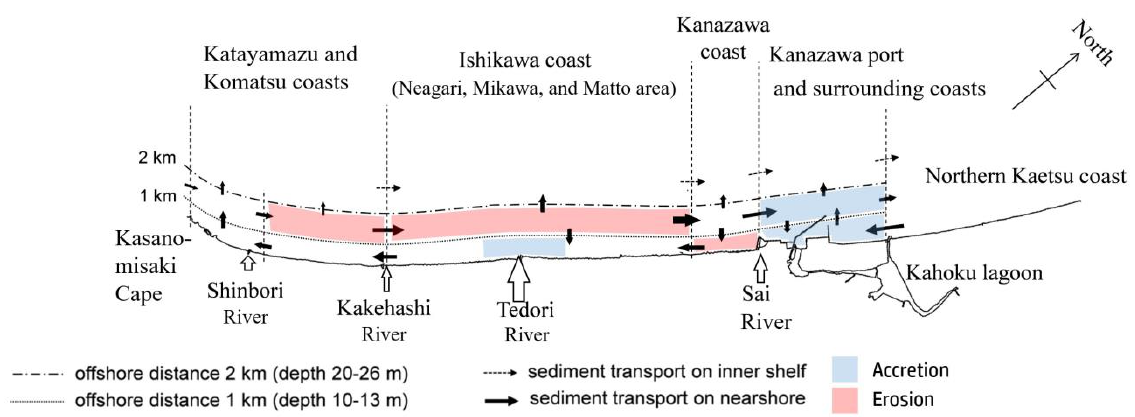
Figure 13. Schematic representation of accretion and erosion along with net sediment transport in the southern part of littoral sediment cell (SLC) analyzed in this study. the southern part of littoral sediment cell (SLC) analyzed in this study.